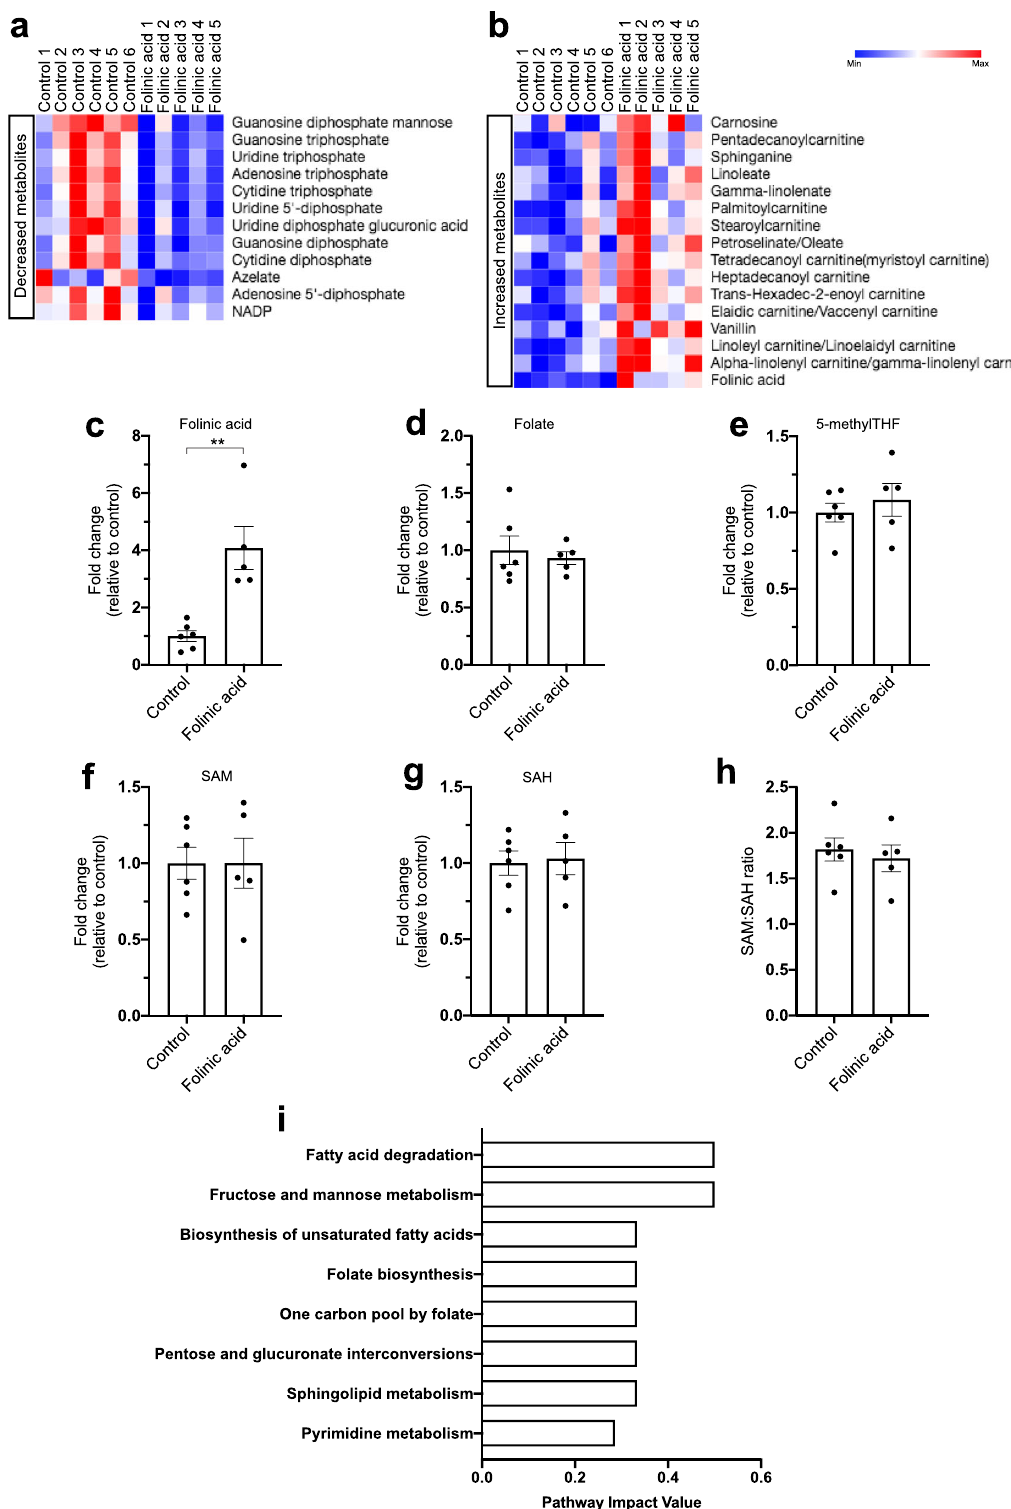
Fig. 6 Metabolomics characterization of folinic acid-treated zebra fi sh larvae following β -cell ablation. a , b Heat-maps showing the signi fi cantly decreased ( a ) and increased ( b ) metabolites upon folinic acid treatment for 24 h, following β -cell ablation in the Tg(ins: fl ag-NTR) line. c – e Changes in the level of folinic acid ( c ), folate ( d ), and 5-methylTHF ( e ) reported as fold change to the untreated zebra fi sh larvae after β -cell ablation following 24 h of folinic acid treatment. n = 6 (control) and n = 5 (folinic acid) biologically independent metabolite preparations from fi ve pooled larvae each were used for the quanti fi cation of this experiment. Data are presented as mean values ± SEM. Mann – Whitney two-tailed test was used to assess statistical signi fi cance. c ** P = 0.0043. f – h Folinic acid treatment does not affect the levels of SAM ( f ), SAH ( g ), or their ratio ( h ). n = 6 (control) and n = 5 (folinic acid) biologically independent metabolite preparations from fi ve pooled larvae each were used for the quanti fi cation of this experiment. Data are presented as mean values ± SEM. i Pathway impact values of zebra fi sh-speci fi c enriched pathways for the signi fi cantly affected metabolites (Fig. 6a, b). NATURE COMMUNICATIONS| (2021) 12:3362 |https://doi.org/10.1038/s41467-021-23673-0|www.nature.com/naturecommunications